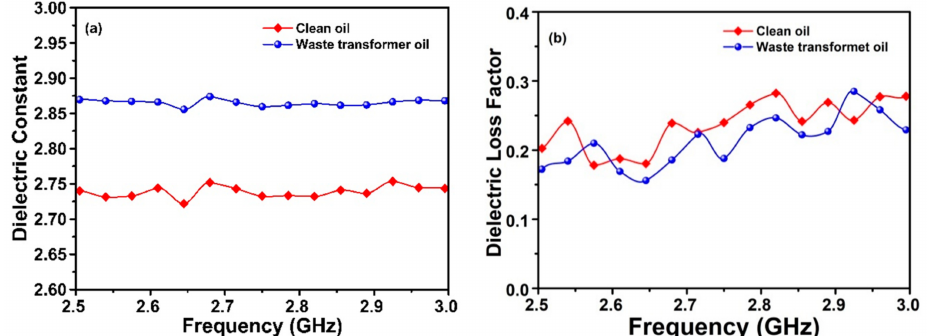
Figure 13. Measured results for the clean and waste transformer oils ( a ) dielectric constant; ( b ) dielectric loss